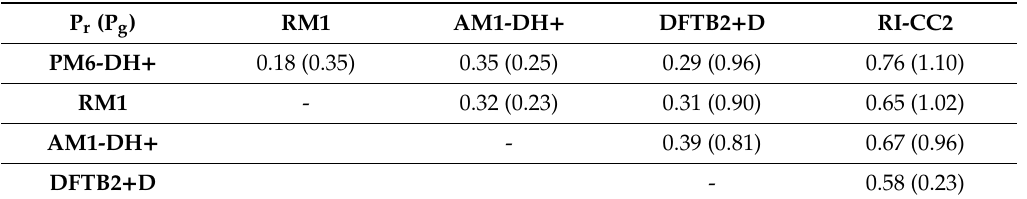
Table 1. Root mean square deviations of geometries in Å. Comparisons are given for methods in the corresponding column and row for P r (first value) and P g (second value, shown in parenthesis). P r (P g